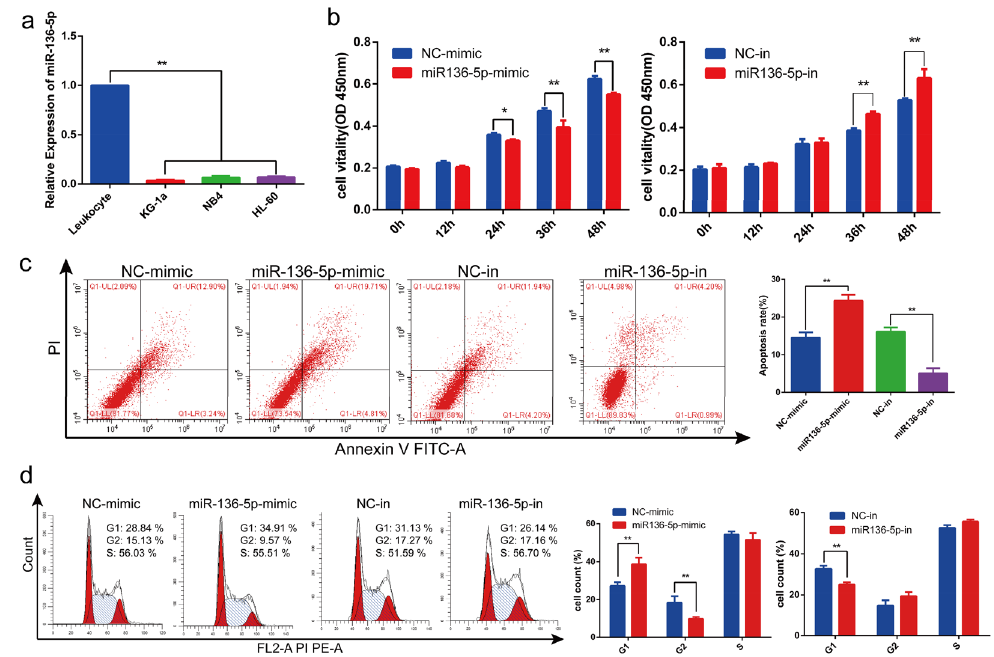
Figure 4. The effects of miR-136-5p on KG-1a cells proliferation, apoptosis and cell cycle distribution. ( a ) QRT- PCR was applied to determine the expression of miR-136-5p in AML cells. ( b ) Cell viability was analyzed by CCK ‐ 8 assay. c Flow cytometry assay was performed to detect the apoptosis rate. ( d ) Flow cytometry assay was performed to detect cell cycle distribution. * p < 0.05, ** p < 0.01.